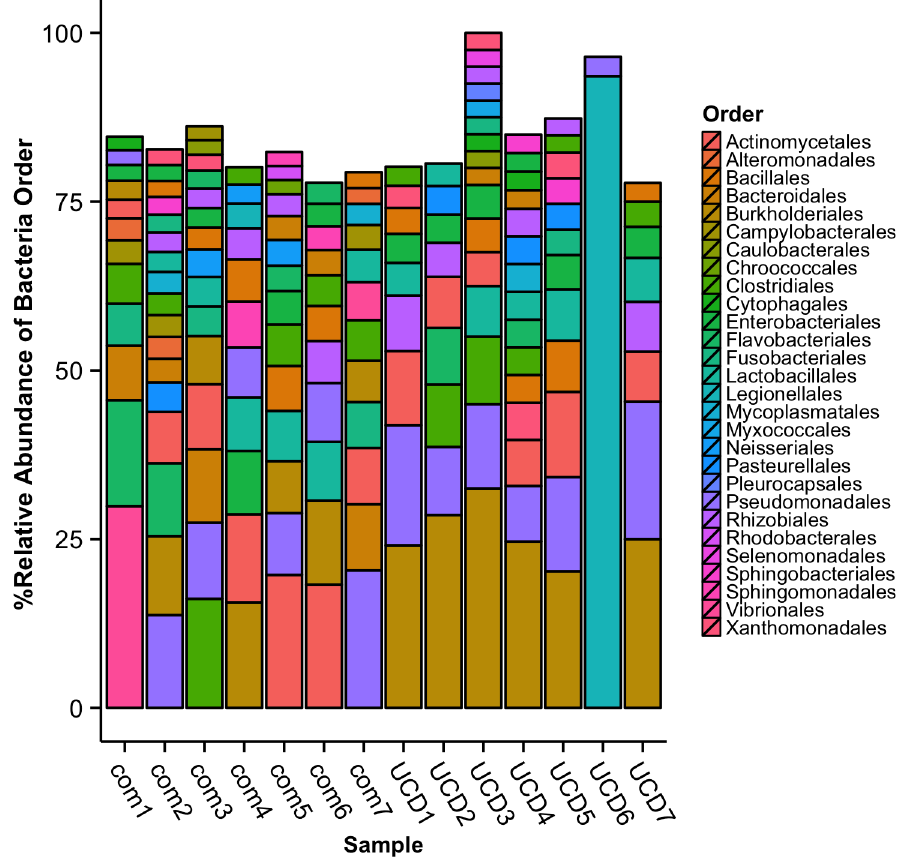
Fig 3. Microbial orders associated with stranded harbor seal brain tissues. Relative abundance of bacterial orders with > 2% relative abundance from comparative (com) and unknown cause of death (UCD) harbor